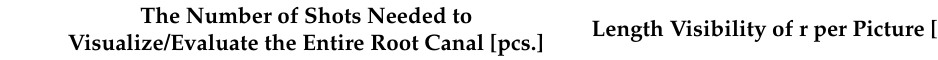
Figure 10. The 3D hologram of tooth 16, is subjected to endodontic treatment due to periodic pain. Table 3. The minimum number of scans for each root canal is needed to analyze its entire course and the percentage of the length of the canal visible on the scan, in the case of the treatment of tooth 16 due to periodic pain.